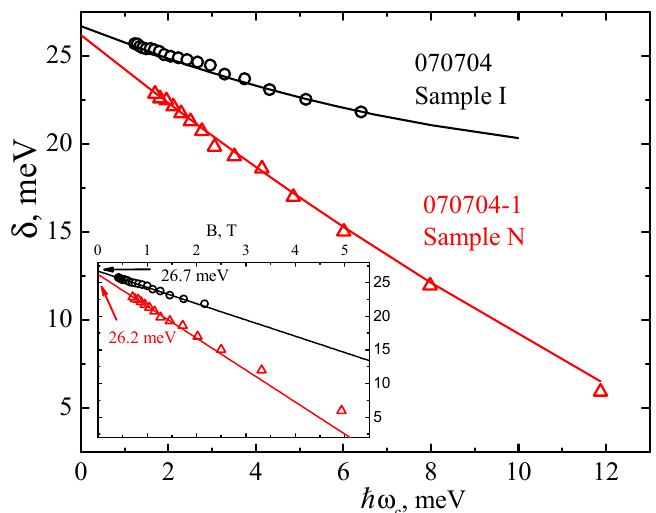
Figure 5. Total experimental spin-splitting energies δ for Sample N (triangles) and Sample I (circles) as a function of ℏ(cid:2033) (cid:3030) . Lines are the fitting according to Equation (10). Inset shows the low field limit, ℏ(cid:2033) (cid:3030) ≪ (cid:2940) (cid:3267) , of Equation (10). The Rashba spin – orbit splitting energies at B = 0, Δ R , obtained by low field fitting are indicated by arrows.